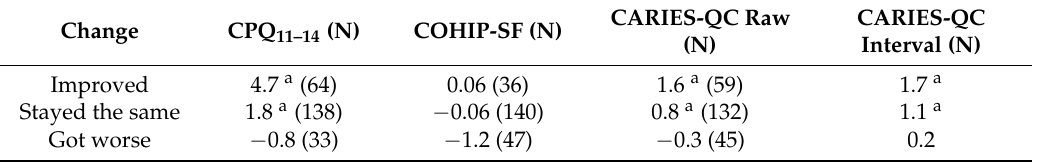
Table 7. Change in mean CPQ 11–14 , COHIP-SF and CARIES-QC scores by change in global